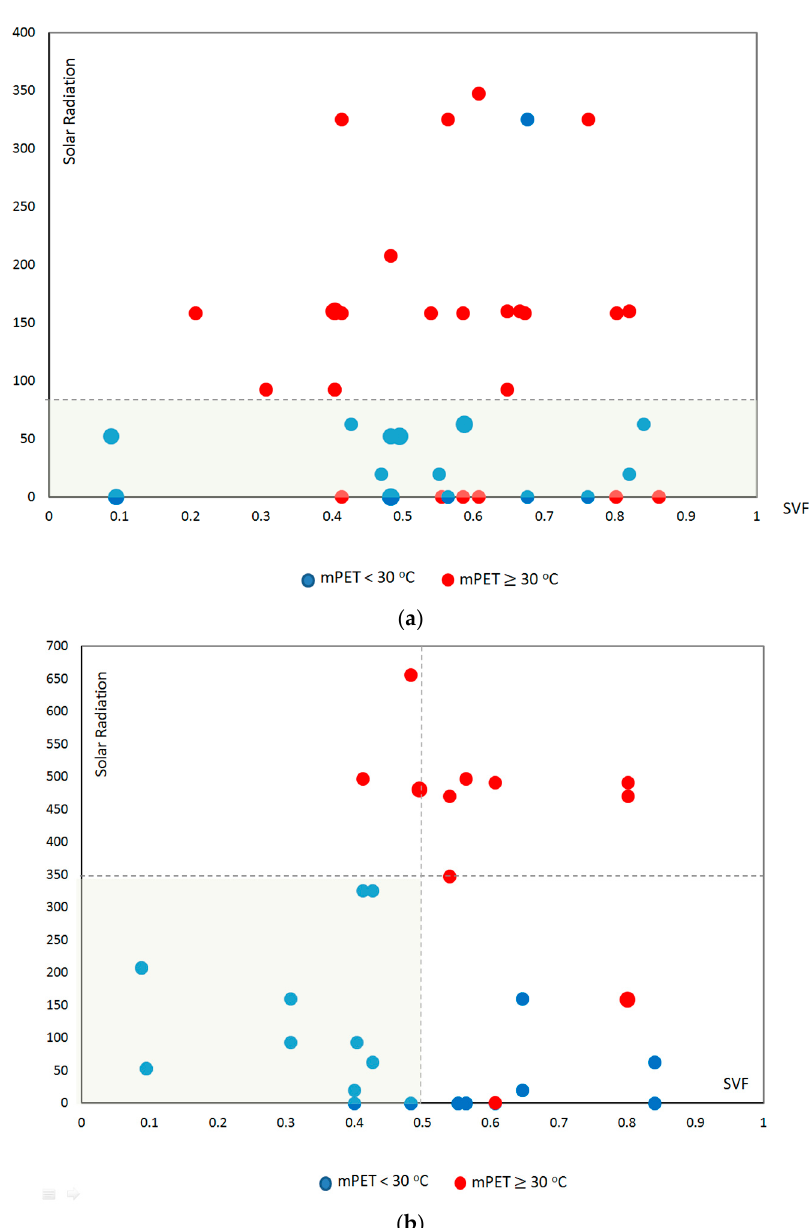
Figure 14. mPET correlation with solar radiation and SVF for runners ( a ) and walkers ( b ).